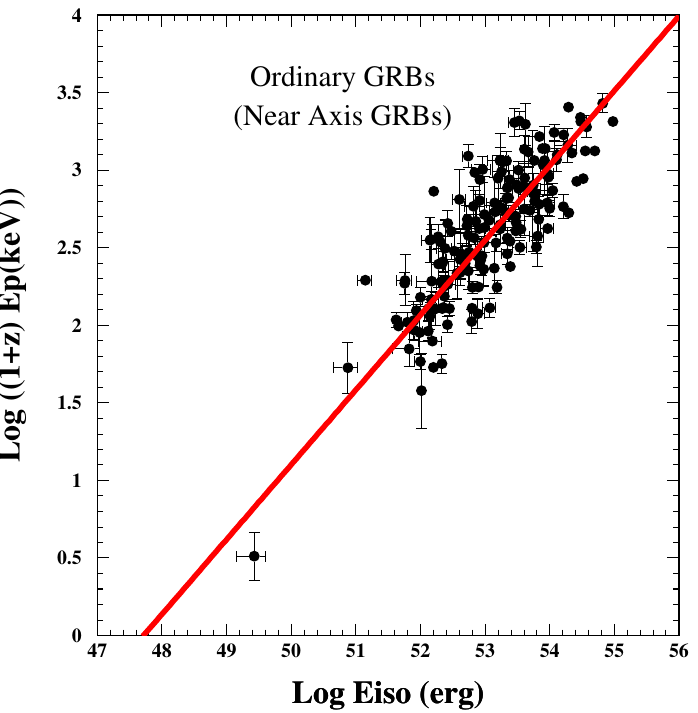
Figure 3. The [ E p , E iso ] correlation in ordinary LGRBs viewed near axis. The line is the best fit, whose slope is 0.48 ± 0.02, consistent with the CB model prediction of Equation (4). The lowest E iso GRB is 020903 at z = 0.25